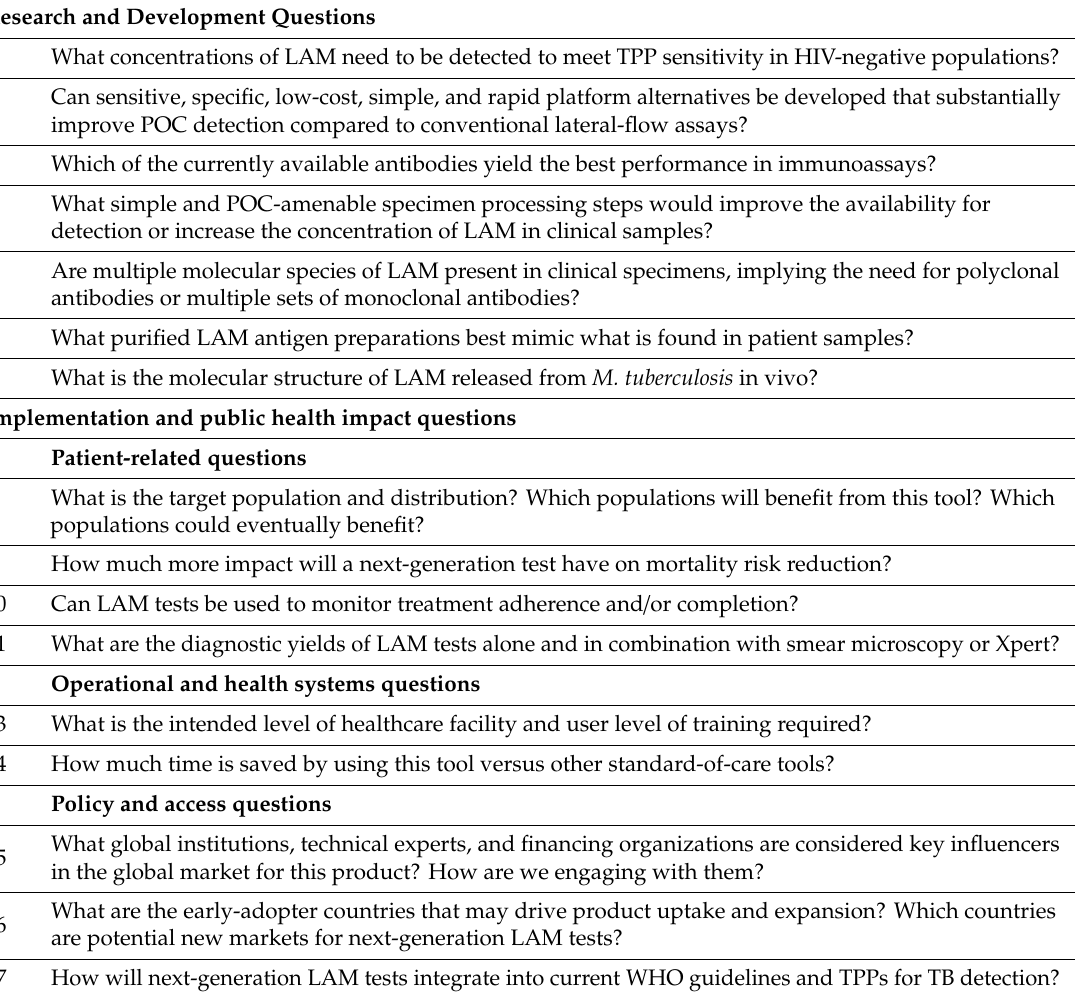
Table 3. Research, development, and implementation questions for future urine Lipoarabinomannan (LAM) Tests. POC: point of